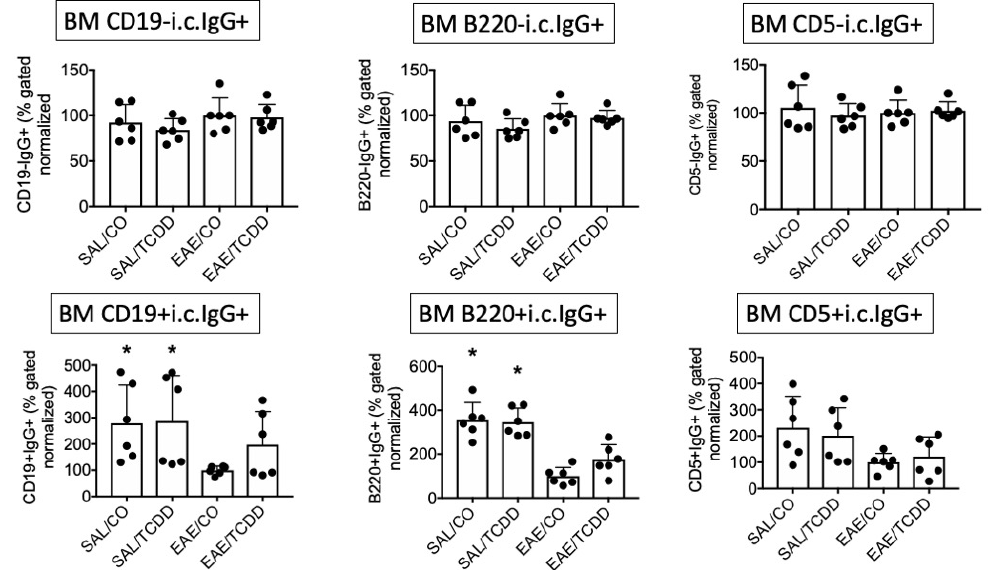
Figure 3. TCDD modestly reversed EAE-induced downregulation of i.c. IgG in BM in EAE. Samples were obtained as in Figure 1, but from BM. * p < 0.05 as compared to EAE/CO using Friedman’s ANOVA and Dunn’s post hoc test. i.c., intracellular; BM, bone marrow. It was interesting to note that the CD19-i.c. IgG+ population had significant overlap with the B220-i.c. IgG+ in SPLC, LN and BM (Figure 4) suggesting these are the same cell population. On the other hand, there was also overlap between the CD19-i.c. IgG+ with CD5+i.c. IgG+ in SPLC and especially in LN (Figure 4, middle